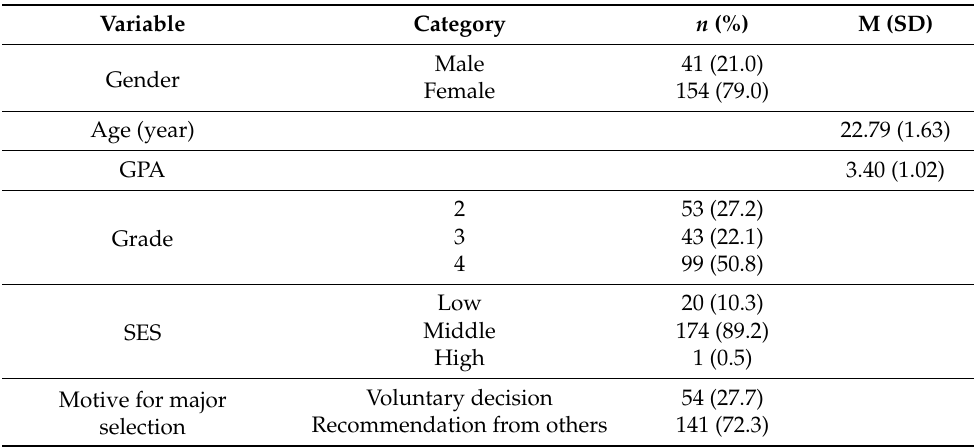
Table 1. General characteristics of participants ( n =